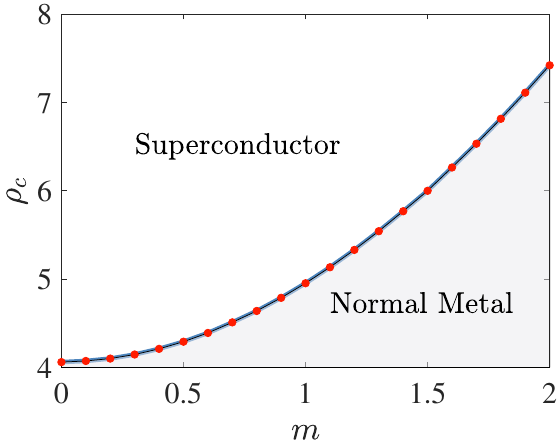
Figure 1 . Critical charge density versus graviton mass. Red dots are numerical results while the blue line is a fitted critical curve. Upper the critical curve the system is in a superconducting phase while below the curve it is in a normal metal phase (shaded